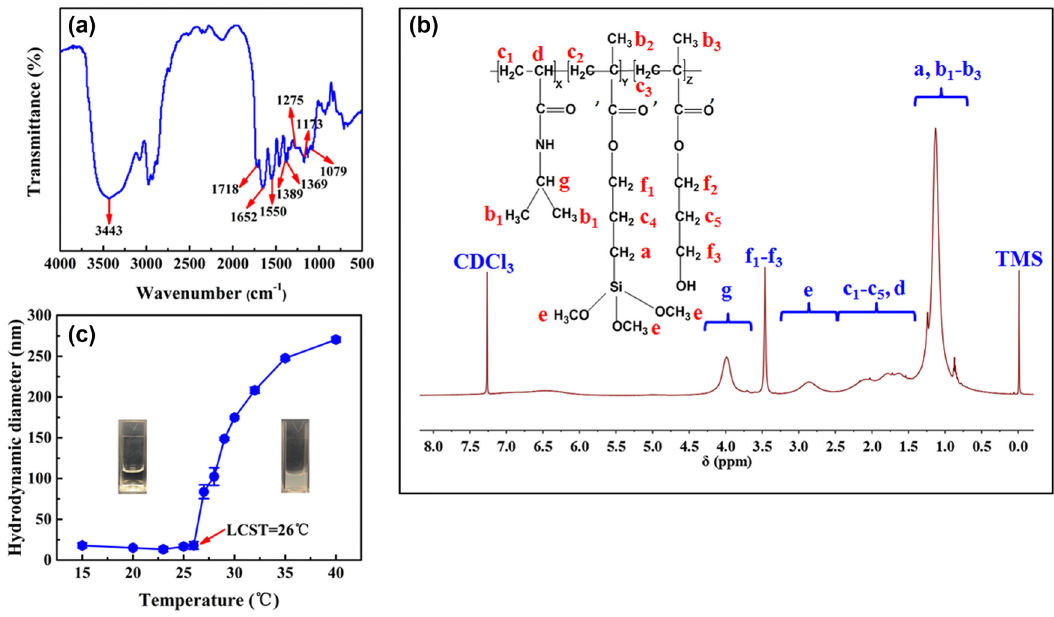
Figure 3: Identi fi cation results of PNIPAAm copolymers: ( a ) FTIR spectrum, ( b ) 1 H - NMR spectrum, and ( c ) DLS